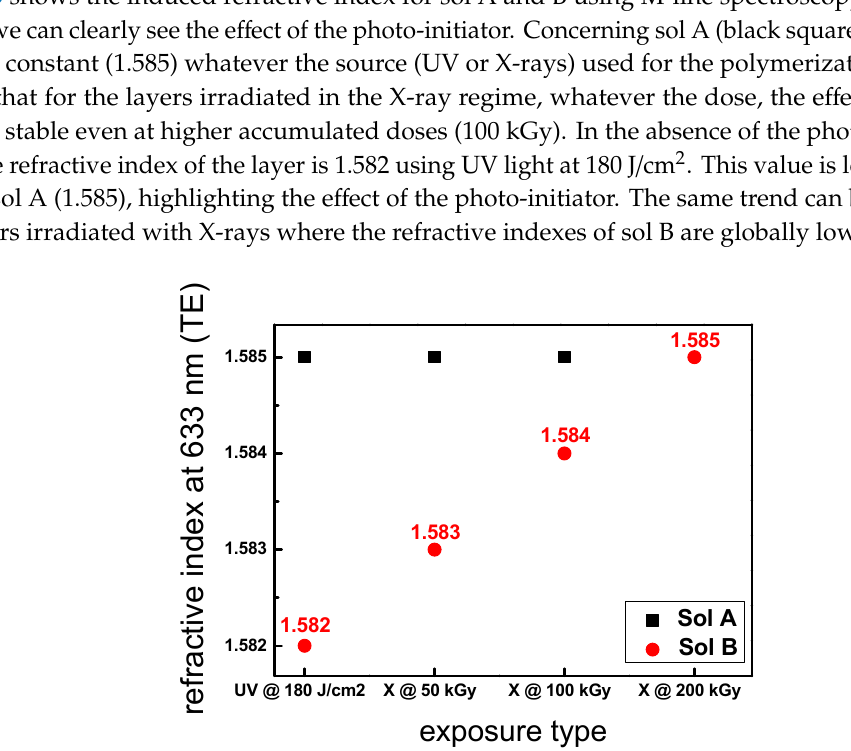
Figure 5. E ff ective refractive index of the layers (sol A and B) at 633 nm in transverse electric (TE) mode for di ff erent exposures: UV (180 J / cm 2 ) and X-rays (50, 100, and 200 kGy). The films were deposited on a Borofloat 33 substrate (n = 1.47 at 633 nm) to ensure an important refractive index change between the layer and the substrate. The precision of the refractive index measurements is 10 − 3 insofar as a high number of guided modes are observed.